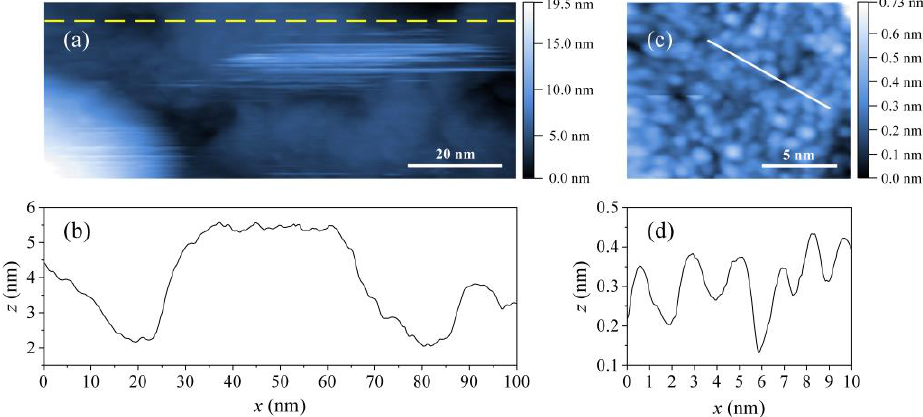
Figure 11. ( a ) The STM topographic image of a 100 × 47 nm 2 area of the sputtered surface of the HTZS-Nb alloy (the matrix phase) at T = 1.2 K, imaged at 300 mV and 30 pA. ( b ) Height profile over a distance of 100 nm, taken along the dashed yellow line drawn in panel (a). ( c ) A 15 × 15 nm 2 STM image of small clusters on the flat surface (imaged at 100 mV and 60 pA). ( d ) Height profile along the 10-nm white line drawn in panel ( c ).